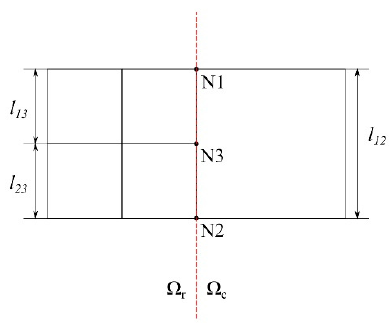
Figure 4. Multiple levels of mesh refinement, where the thinner lines represent the new element edges after refinement. Ω (cid:3045)(cid:2869) , Ω (cid:3045)(cid:2870) , and Ω (cid:3045)(cid:2871) refer to the domain of first, second, and third level of refinement, respectively.